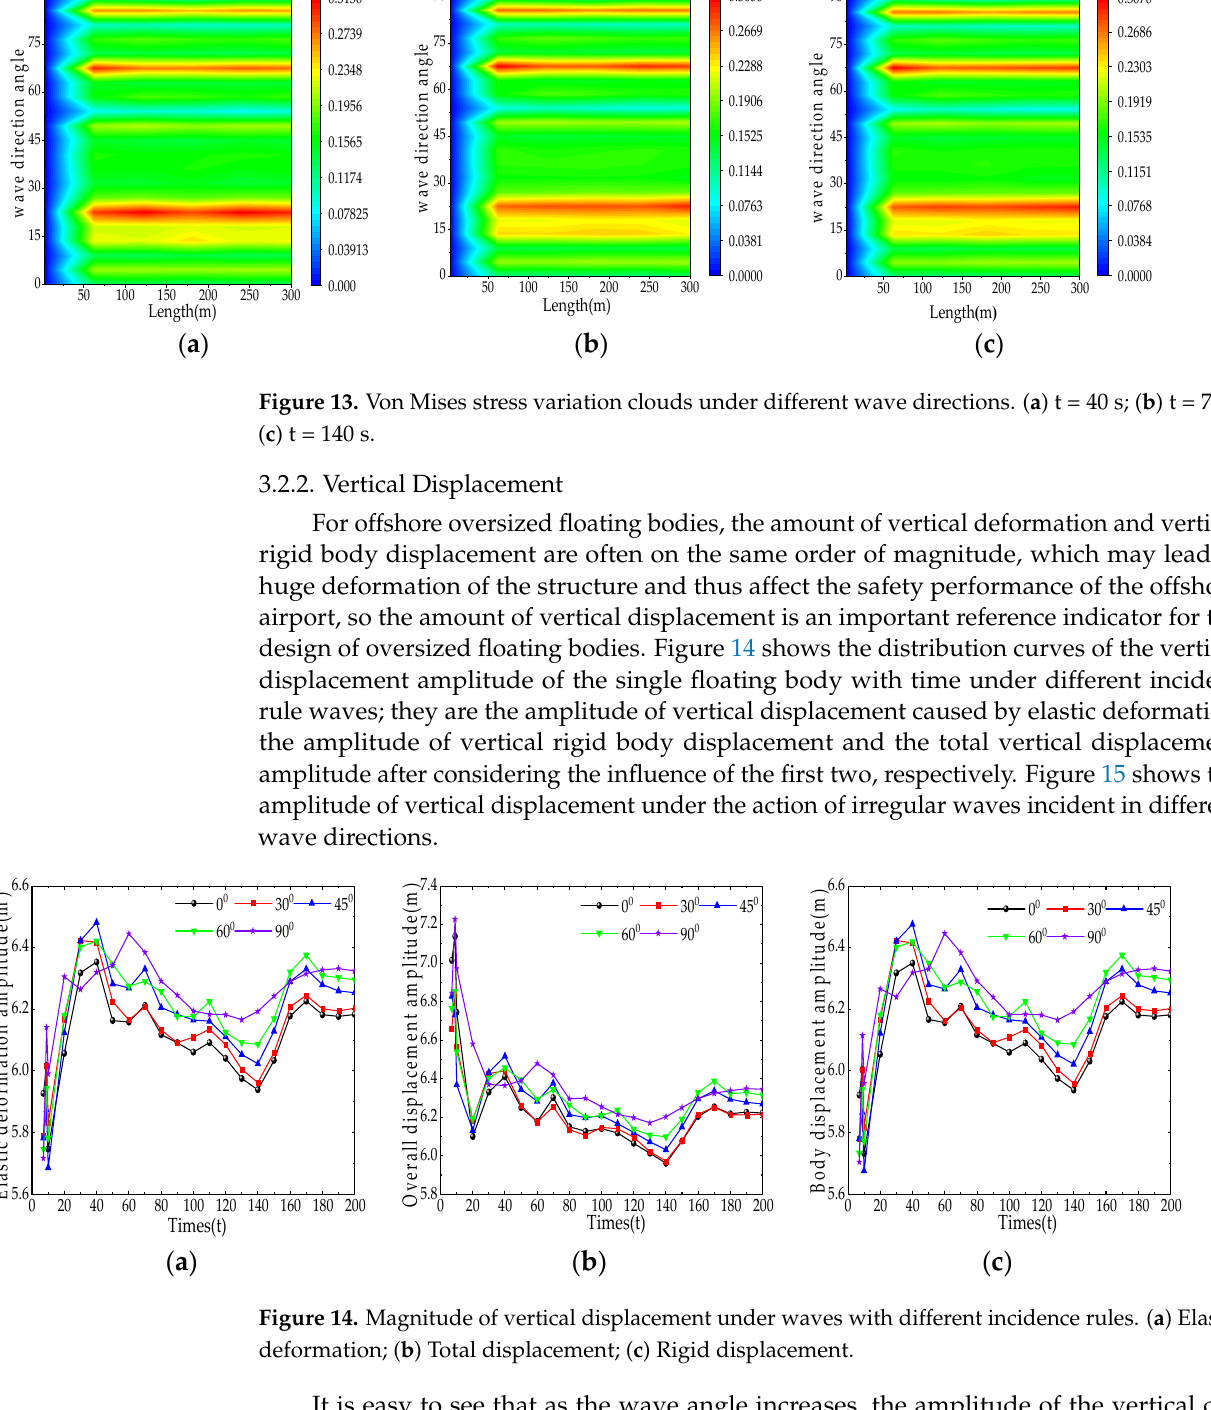
11 of 14 Figure 11. Time course curve of rigid body displacement under different incident irregular waves. ( a ) Pendulum response curve; ( b ) Transverse rocking response curve; ( c ) Longitudinal rocking re- sponse curve. From Figure 12, it is easy to find that the overall displacement under the same wave angle is always greater than the elastic deformation and rigid displacement, and the elastic deformation is greater than the rigid displacement, but the overall displacement is not a simple superposition of the two. Taking 0° as an example, the overall displacement max- imum is 6.0187 m, the elastic deformation displacement maximum is 6.017 m, and the rigid displacement maximum is 6.016 m. So, it can be seen that for the offshore floating body, the scale is huge, and its elastic deformation should not be ignored. Furthermore, regardless of the wave angle, the difference between the three displacement amplitudes along the floating body distribution is small, but with the increase of the wave direction, the amplitude growth is more obvious. Especially when the wave angle is 90°, the ampli- tude reaches its maximum value when the safety of the floating body at sea is put to a greater test. ( a ) ( b ) ( c ) Figure 12. Three-dimensional cloud map of the variation of vertical displacement amplitude with floating body length under different wave directions. ( a ) Elastic deformation; ( b ) Rigid displace- ment; ( c ) Overall displacement. Figure 13 gives a cloud plot of the Von Mises stress variation along the float length when the float is loaded downward to 40, 70, and 140 s at different waves. From the figure, one can obviously see the distribution law of stress value with the change of floating body length: regardless of the wave direction angle, when the floating body is in the path of an incoming wave within 50 m that is slowly increasing, and the stress concentration is at 50 m with a triangular distribution, which is extremely unfavorable, the stress tends to be